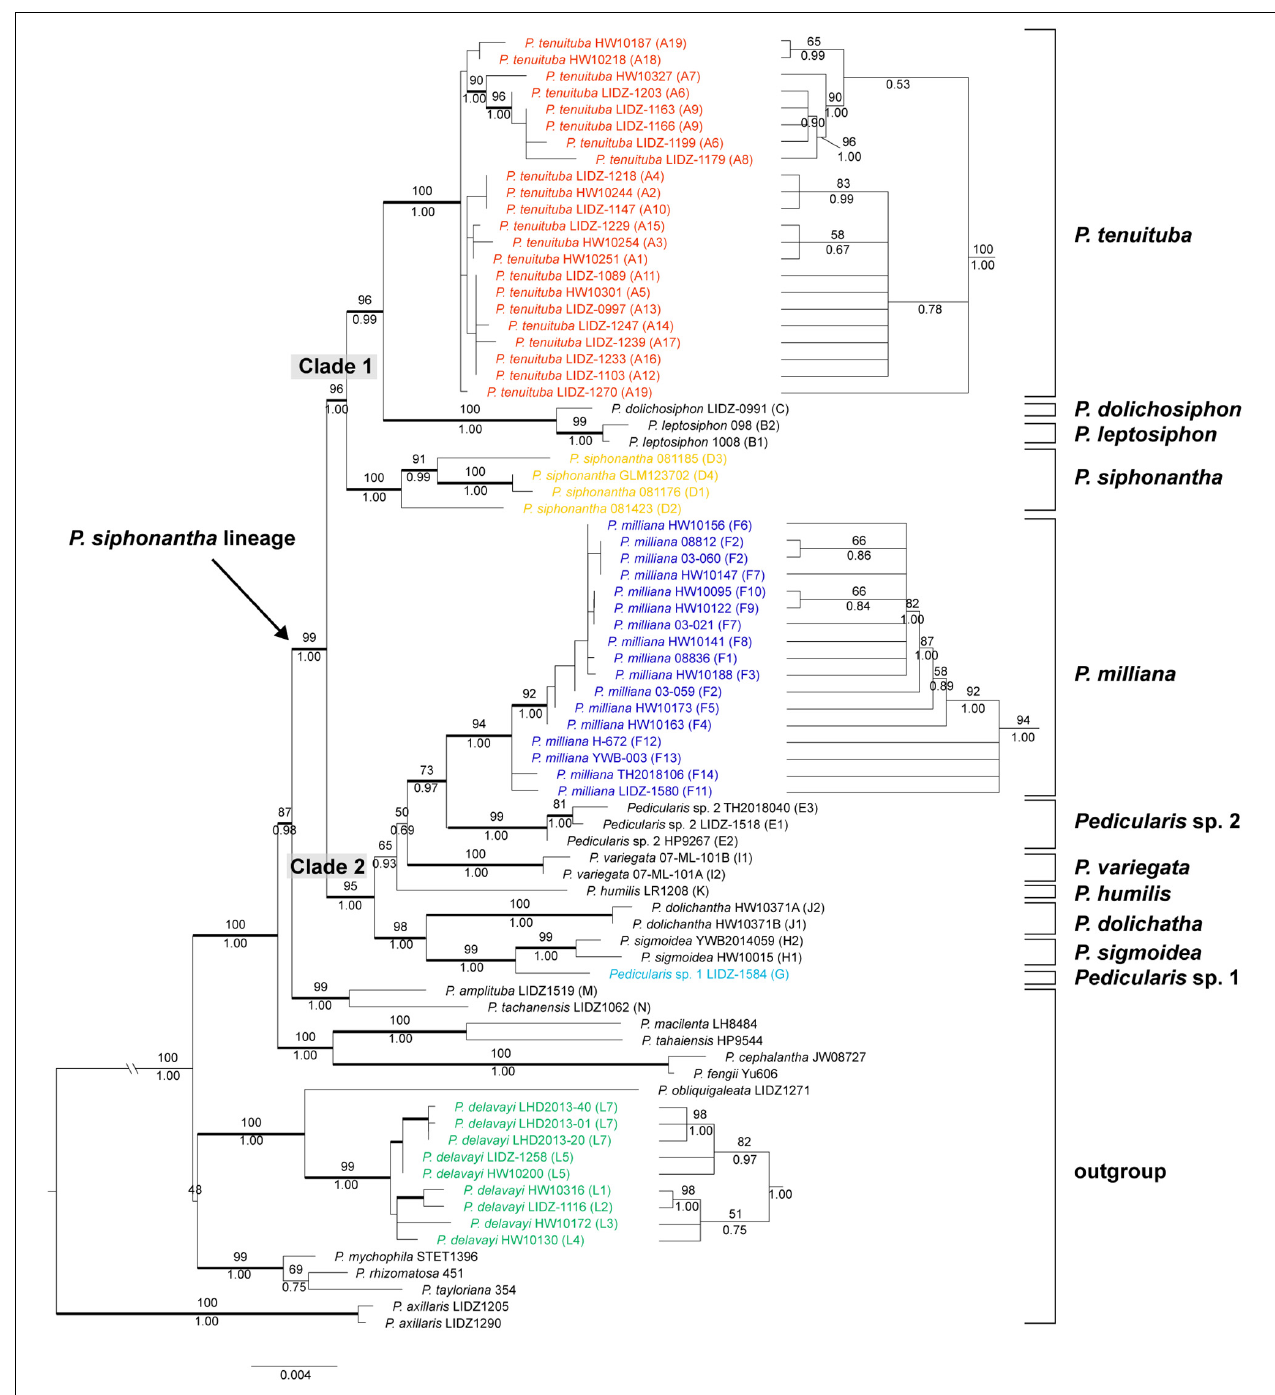
FIGURE 5 | Bayesian inference (BI) tree of the Pedicularis siphonantha complex inferred from the modified nrITS+ptDNA dataset by removing the conflicting sequence nrITS of Pedicularis dolichosiphon (nrITS) and the four ptDNA regions ( matK , rbcL , trnH-psbA , and trnL-F ) of the samples F11-F14 of Pedicularis milliana in accordance with the topological incongruence between the nrITS and ptDNA phylogenies (see Figure 4 and Table 3 ). Numbers associated with the branches are ML BS value and BI PP, and thicker lines indicate BS ≥ 70 and PP ≥ 0.95. Node with BS < 50 was collapsed. The topology of the P. milliana clade with short branch lengths appear on the